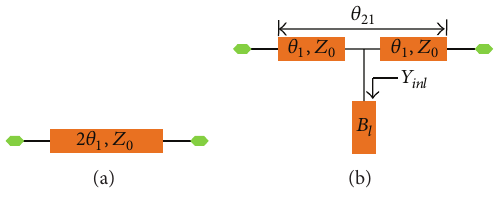
Figure 1: (a) Conventional transmission line. (b) The length- reduced transmission line with a reactance part.